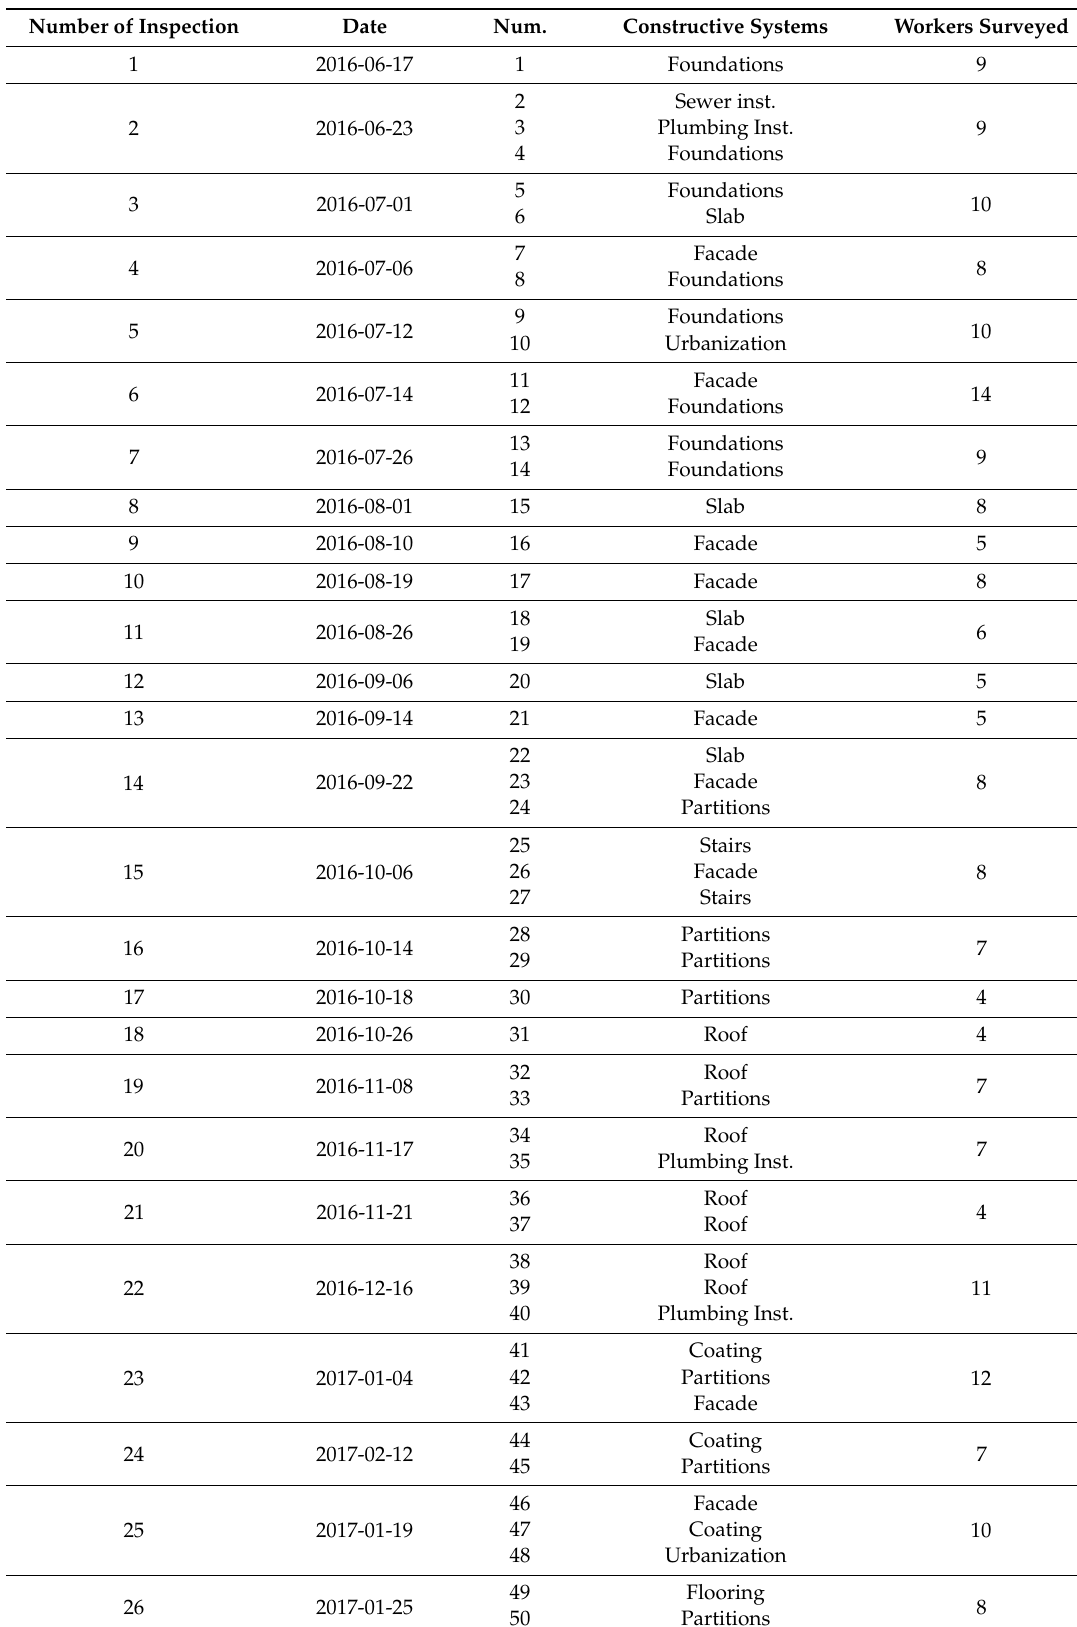
Table 1. Chronology of the data collection